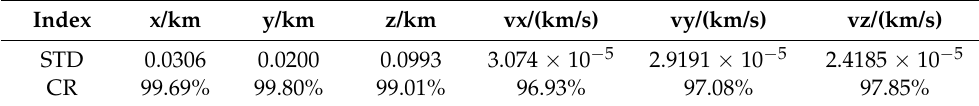
Table 4. Final STD and CR results for the two-spacecraft OD system in general cases.